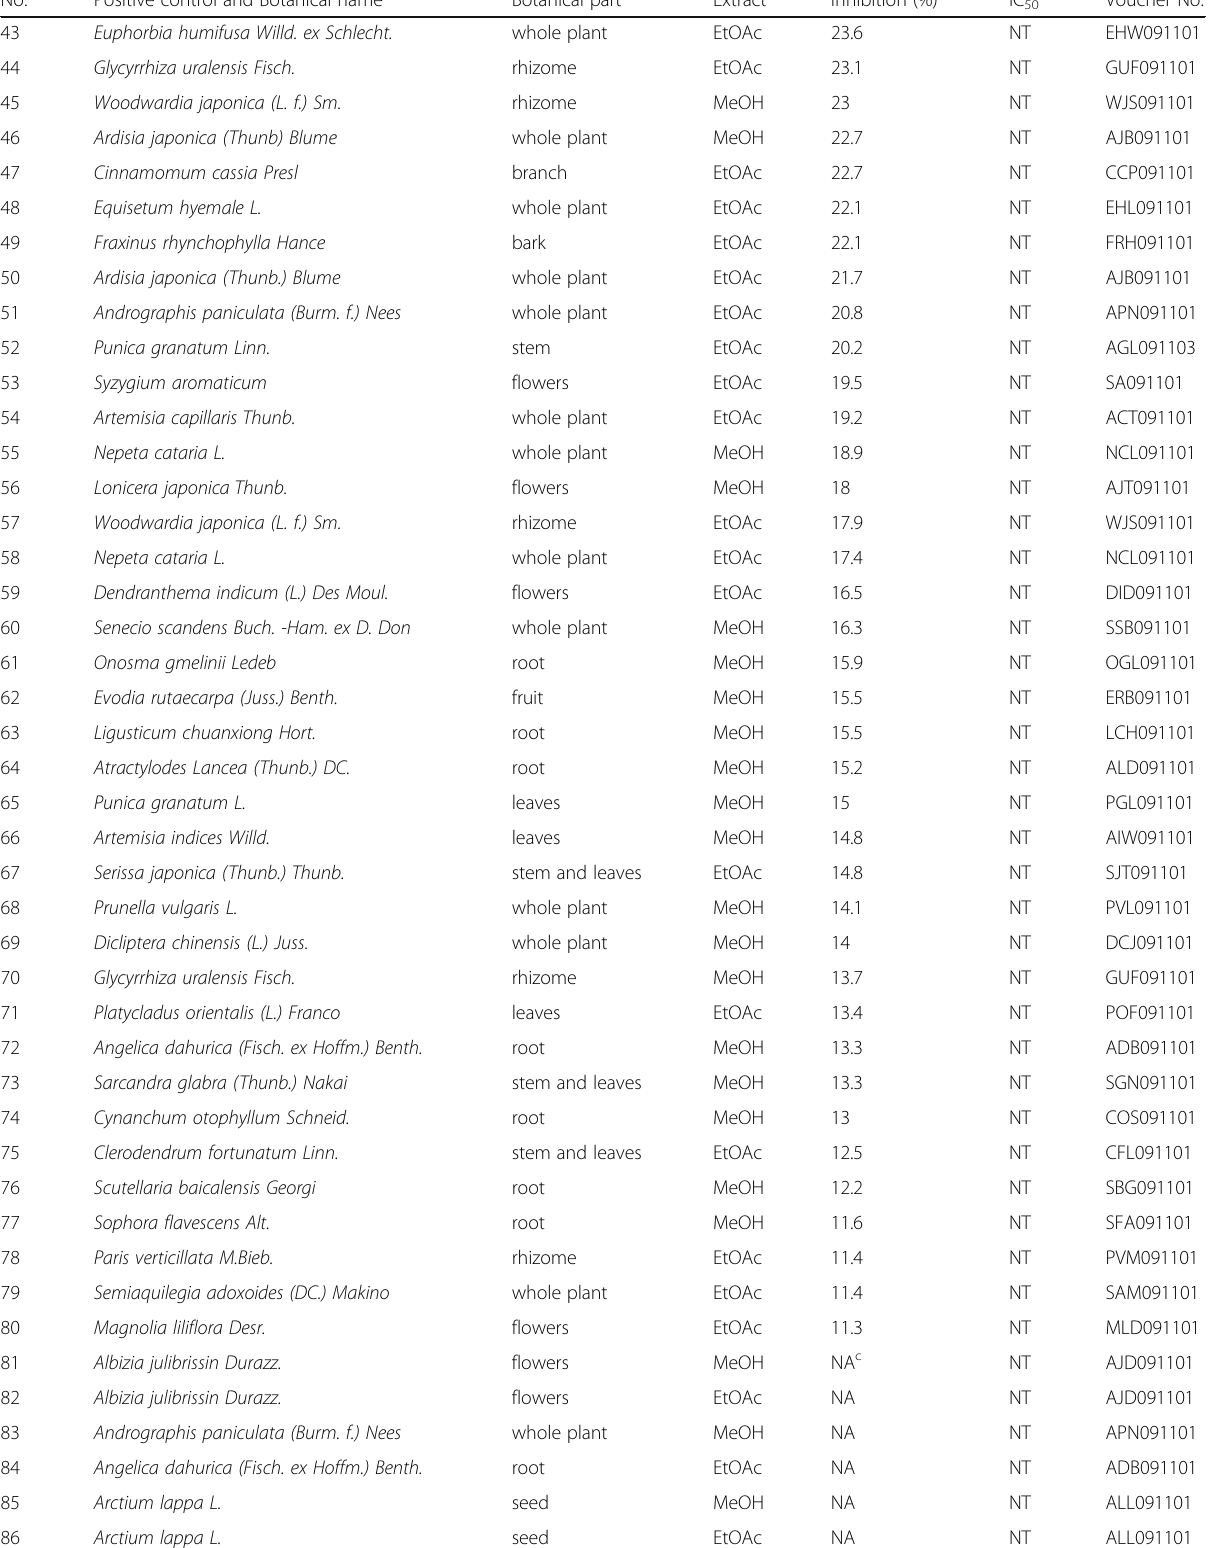
Table 1 Inhibitory activities of Chinese herbs extract on A(H1N1) influenza virus neuraminidase (Continued) No. Positive control and Botanical name Botanical part Extract Inhibition (%) a IC 50b Voucher